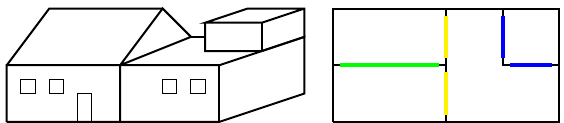
Figure 1. Neighborhood of roof segments: The left figure shows the 3D building, the right figure shows the building from the bird’s eye view. Green: Two segments intersect in a cut line (N1); yellow: two segments touch each other in a point or a segment of insu ffi cient length (N2); blue: two segments are neighbors in 2D but not in 3D